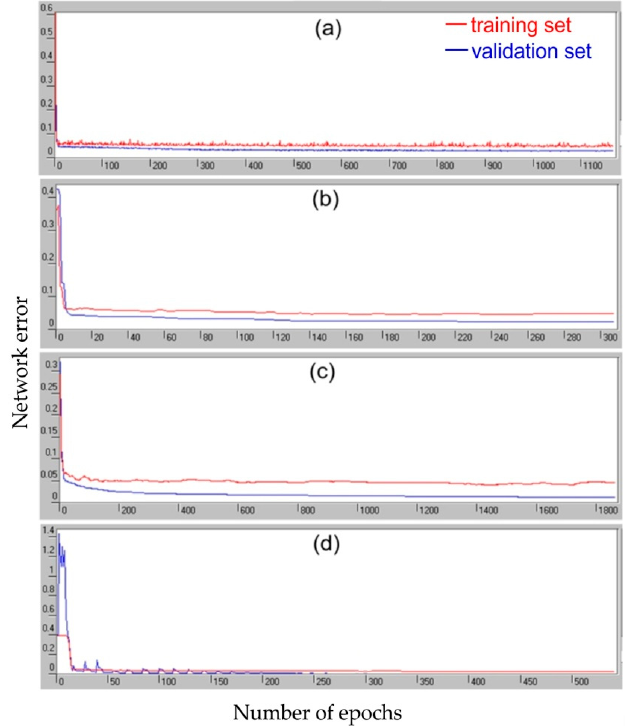
Figure 24. Variation of network errors during the training process with the algorithm: ( a ) back propagation, ( b ) conjugate gradients, ( c ) quasi-Newton and ( d ) Levenberg–Marquardt.